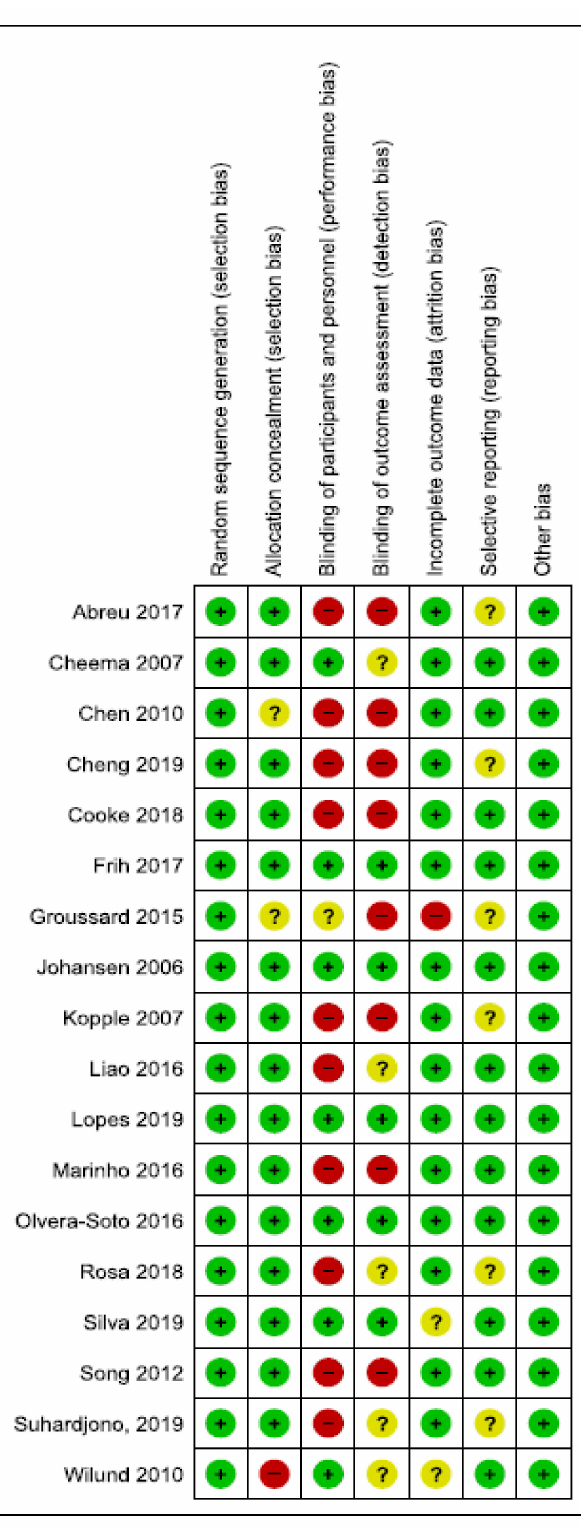
Figure 3. Risk of bias summary for included